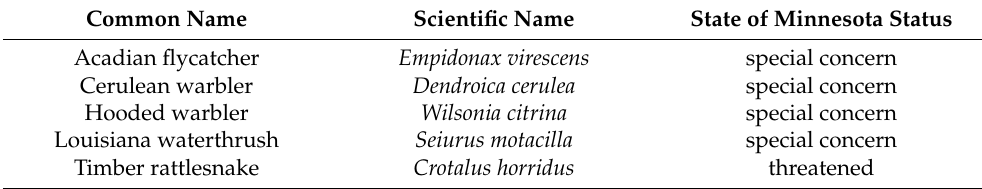
Table 1. Five threatened, endangered, or special concern species in the state of Minnesota and their listing status according to the state of